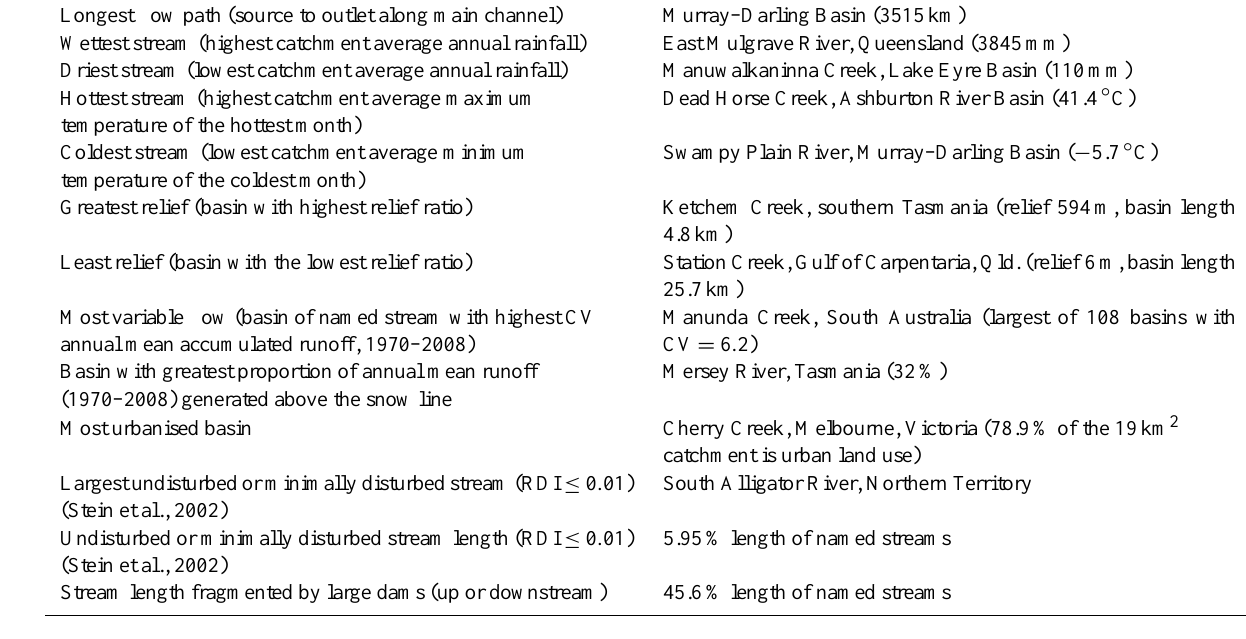
Table 4. Characteristics of Australian streams and catchments: examples derived from the environmental descriptors for a subset of named streams.